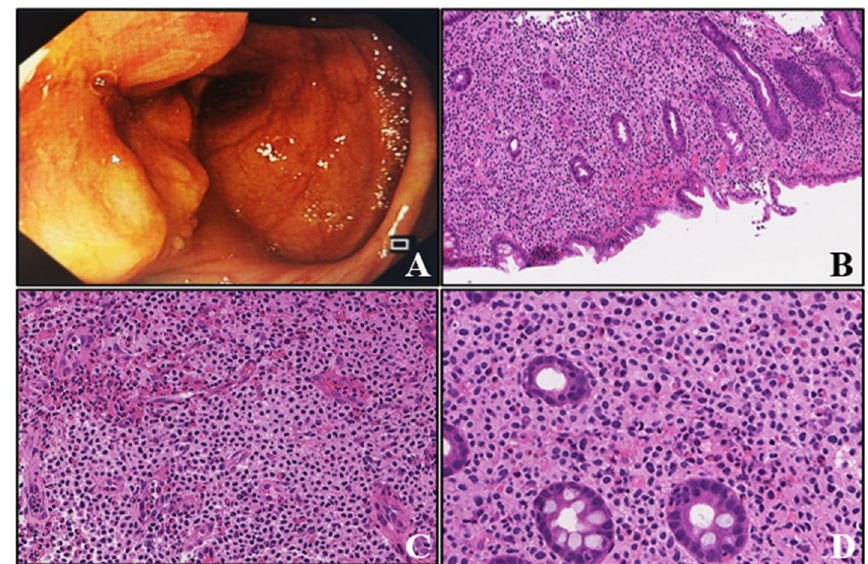
Fig. 1 Endoscopic and morphological findings of the patient with systemic mastocytosis. A Colonoscopy showing a 3.0 cm lesion in the cecum with erosion, necrosis, and ulcer formation on the surface. B Biopsy specimen of the intestinal lesion depicted in ( A ), showing expanded lamina propria by medium-sized mast cells (hematoxylin and eosin stain, a mixture of eosinophil cells (hematoxylin and eosin stain, hyperchromatic nucleus (hematoxylin and eosin stain,